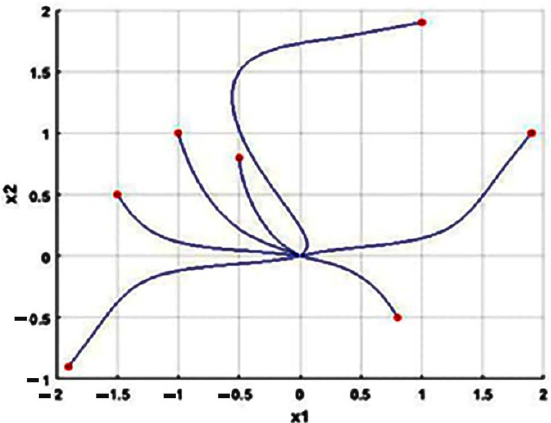
Figure 2. Phase portrait of 𝑥 (cid:2869) (𝑡), 𝑥 (cid:2870) (𝑡) for PFDE nonlinear system (28).